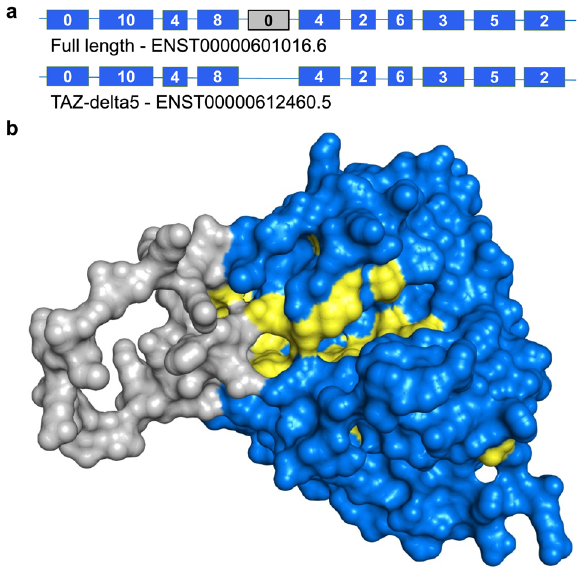
Fig. 1 The “ full-length ” splice variant of TAFAZZIN . a The two most studied TAFAZZIN transcripts. The “ full-length ” transcript has 11 exons, the likely main functional transcript (TAZ-delta5) has ten. The inserted exon 5 is shown with a grey background. Exons are not to scale. The number of ClinVar 10 pathogenic and likely pathogenic variants that map to each exon is shown inside the exon. Only exon 1 (the trans-membrane helix) and exon 5 have no ClinVar pathogenic variants. b The model of the “ full-length ” isoform of TAFAZZIN generated by AlphaFold 45 for UniProtKB, showing the predicted protein surface. The inserted loop from exon 5 is shown in grey. Residues coloured in yellow are 100% conserved in an alignment of tafazzin from 10 species, human, mouse, zebra fi sh, fruit fl y, cockroach, orbweaver spider, chickpea, potato, mushroom and slime mould. These are the most important residues in the binding cleft/ catalytic site region. The inserted loop blocks this region.